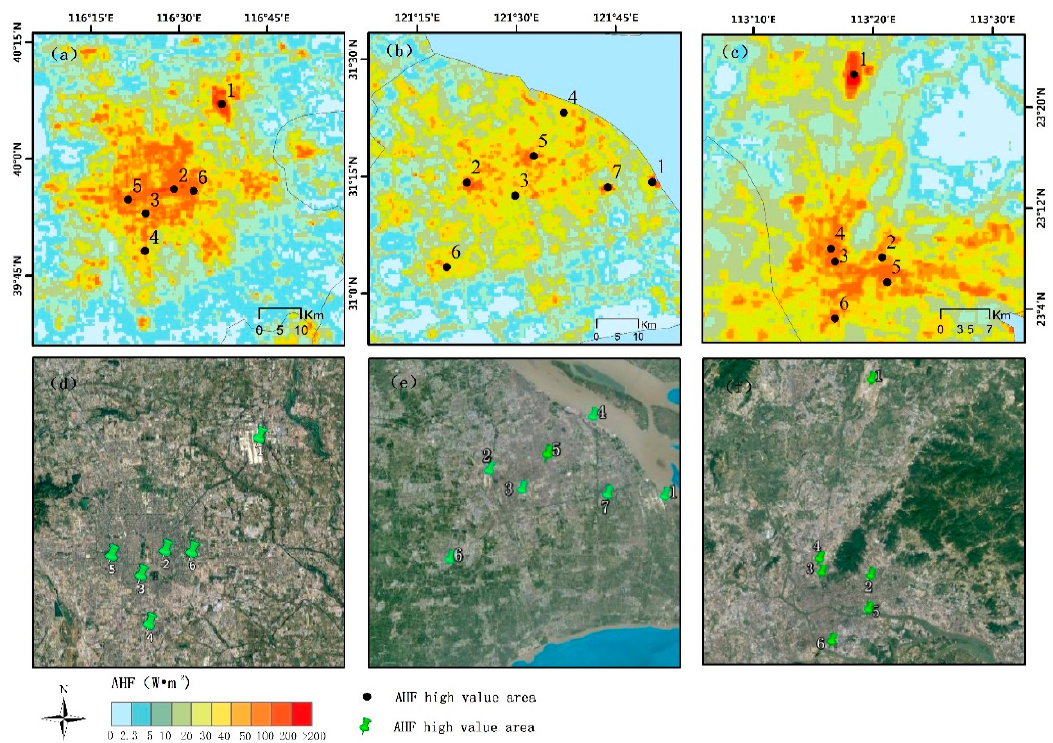
Figure 6. The AHF estimation results and high-value area distribution validation of cities. ( a ) Beijing; ( b ) Shanghai; ( c ) Guangzhou; ( d – f ) high-resolution images of corresponding cities. Note: ( a , d ): 1. Beijing capital international airport; 2. Beijing railway station; 3. Beijing south railway station;4. Beijing Nanyuan airport; 5. Beijing west railway station; 6. Beijing east railway station; ( b , e ): 1. Shanghai Pudong international airport; 2. Shanghai Hongqiao airport; 3. Shanghai south railway station; 4. Shanghai Gaodong helipad; 5.Oriental Pearl Tower; 6. Songjiang south station; 7. Shanghai Disney; ( c , f ): 1. Guangzhou Baiyun airport; 2. Guangzhou east railway station; 3. Guangzhou station; 4. Tangxi railway station; 5. Canton Tower; 6. Industry zone. Table 2. Comparison of AHF estimation results in this study with the existing AHF results. The Sample